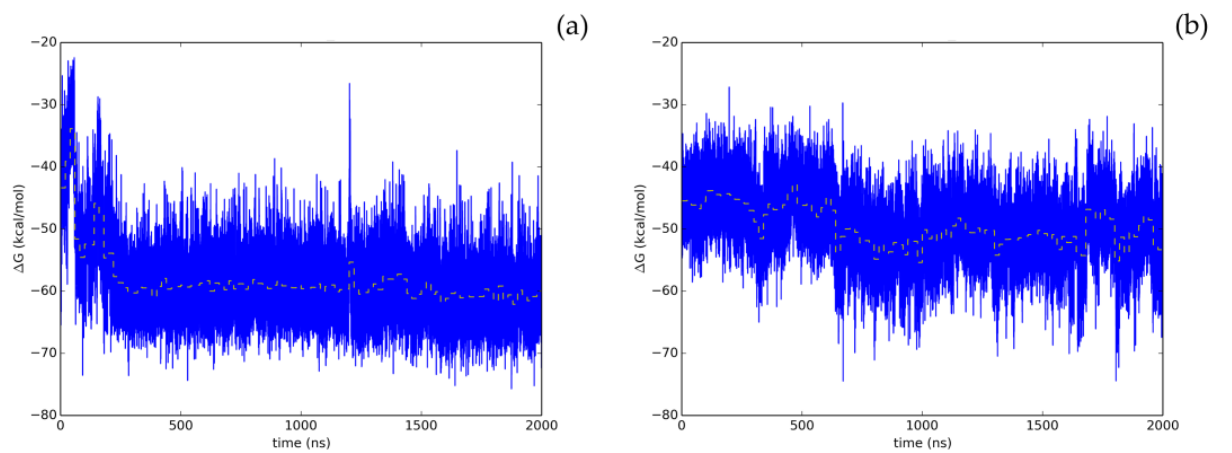
Figure 3. Time evolution of the thermal MMGBSA binding free energy obtained from the full length extended molecular dynamic simulations for the two allosteric binding sites identified for Hyperoside. Energetics profiles shown correspond to the first ( a ) and second ( b ) binding poses exhibiting the best energetic profiles, with computed average binding energies during the last 20 ns of − 60.1 kcal/mol and − 53.3 kcal/mol, respectively. Average binding energies computed every 20 ns of the simulation are depicted in the graphs as a yellow dashed line.